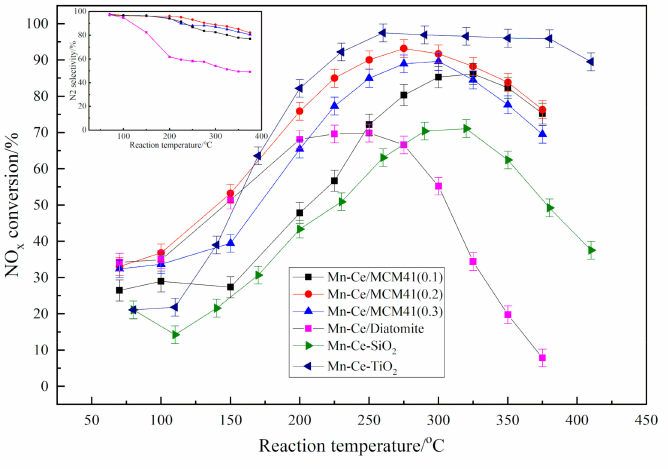
Figure 11. Denitration activity and N 2 selectivity of catalytic